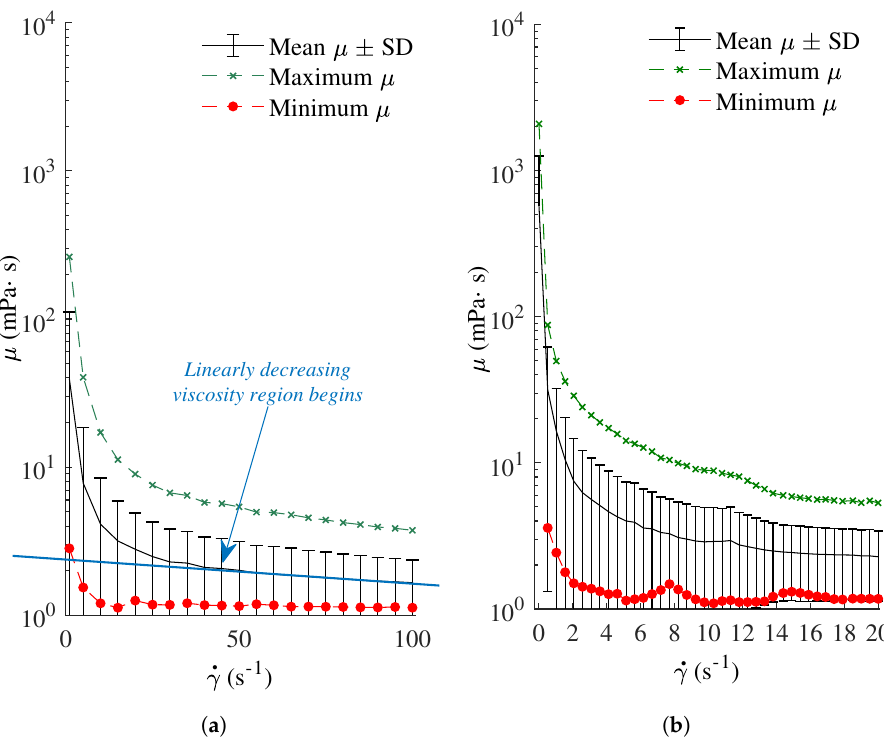
Figure 1. Shear-thinning flow behavior of human milk. Raw human milk demonstrates shear-thinning flow behavior with µ decreasing as ˙ γ increases. The maximum and minimum µ values for each Shear Rate Sweep Test are presented to show the range of data in comparison with the mean and SD. ( a ) Shear Rate Sweep Test #1 (1–100 s − 1 ) shows a continuously decreasing slope that never reaches Newtonian. ( b ) Shear Rate Sweep Test #2 highlights lim ˙ γ → 0 µ → ∞